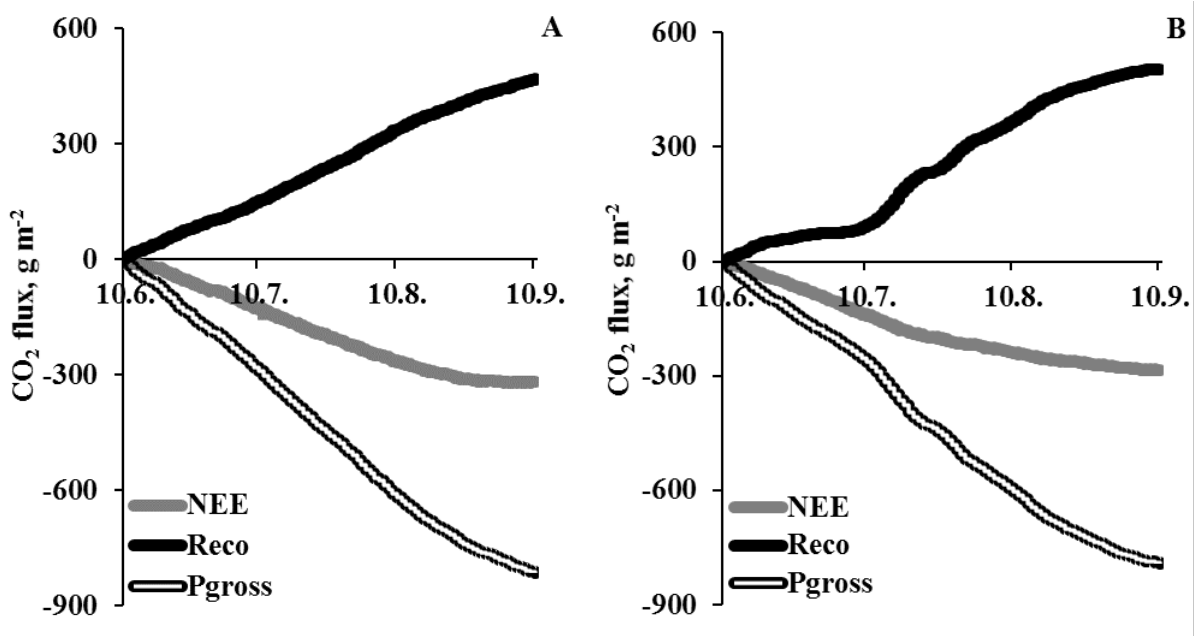
Figure 5. Cumulative sums of carbon dioxide exchange (g m -2 ) for the growing seasons (10 June to 10 September) of (A) 2012 and (B)